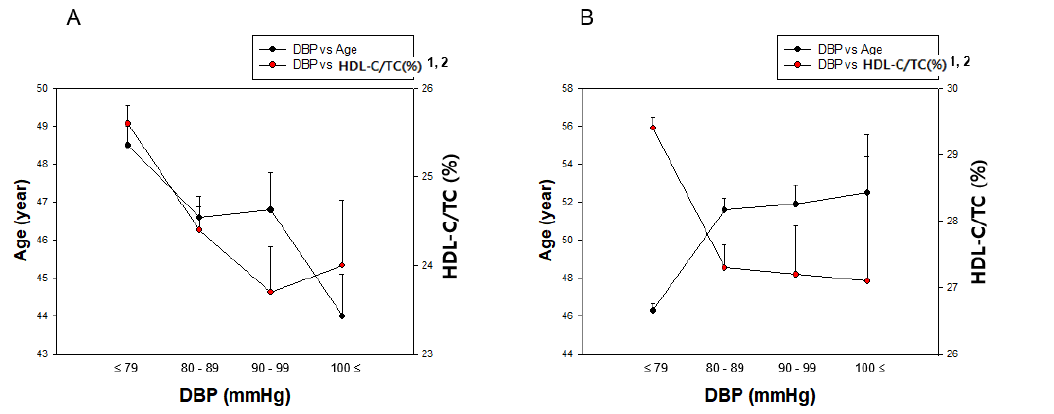
Figure 7. Pearson’s correlation analysis was carried out among age, HDL-C / TC (%), and DBP in men ( A ) and women ( B ). Men (A) showed r = − 0.136 ( p < 0.001) and women (B) showed r = − 0.152 ( p < 0.001) between DBP and HDL-C/TC (%).